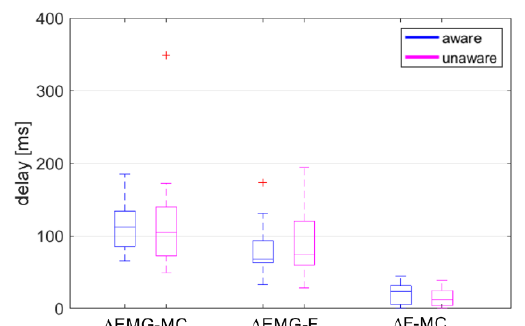
Figure 4. Time delays estimated with cross-correlation between EMG, MC neck, and neck-muscle load F. Positive sign of ∆ indicates that the MC neck is delayed relative to the EMG ( ∆ EMG-MC), the F is delayed relative to the EMG ( ∆ EMG-F), and the MC neck is delayed relative to F ( ∆ F-MC). Depicted: median value, 25th- and 75th-percentile values, min-max range and outliers (red), aware (blue), unaware (magenta). Table 3. Maximum values of coefficients r estimated with cross-correlation between EMG, MC neck and neck-muscle load F; mean ± SD and median (min/max).